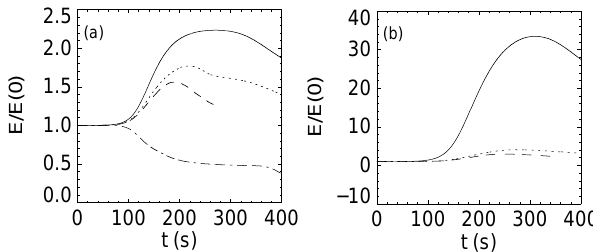
Fig. 11. Evolution of total perturbation energy normalized by the initial energy. Same cases as in Fig. 10. (a) U m = − 0 . 1ms − 1 . (b) U m =− 0 . 2ms − 1 .